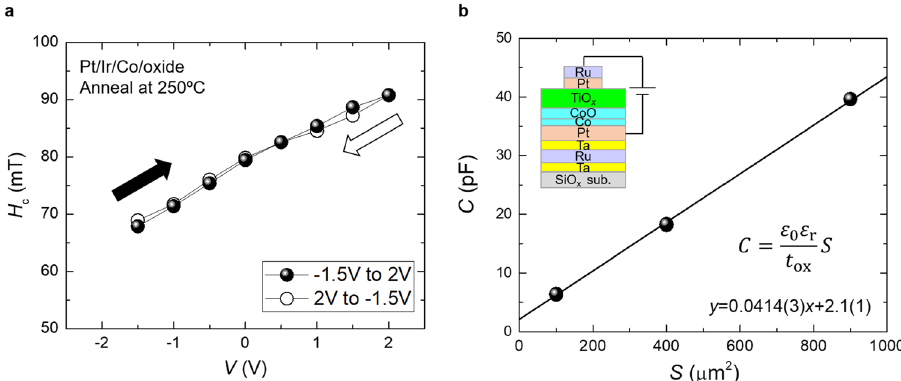
Figure 5. ( a ) Bias-voltage-dependence of H c of Ir-inserted sample (post annealed at 250 °C). The bias-voltage was applied in order: from − 1.5 V to 2.0 V (ascending branch, black closed circles) and from 2.0 V to − 1.5 V (descending branch, black open circles). ( b ) Device size ( S ) dependence of device capacitance ( C ) of nominal SiO x sub./Ta (5 nm)/Ru (10 nm)/Ta (5 nm)/Pt (10 nm)/Co (1.7 nm)/TiO x (5 nm)/Pt (5 nm)/Ru (2 nm)) sample. The simple schematics of the device is shown in the